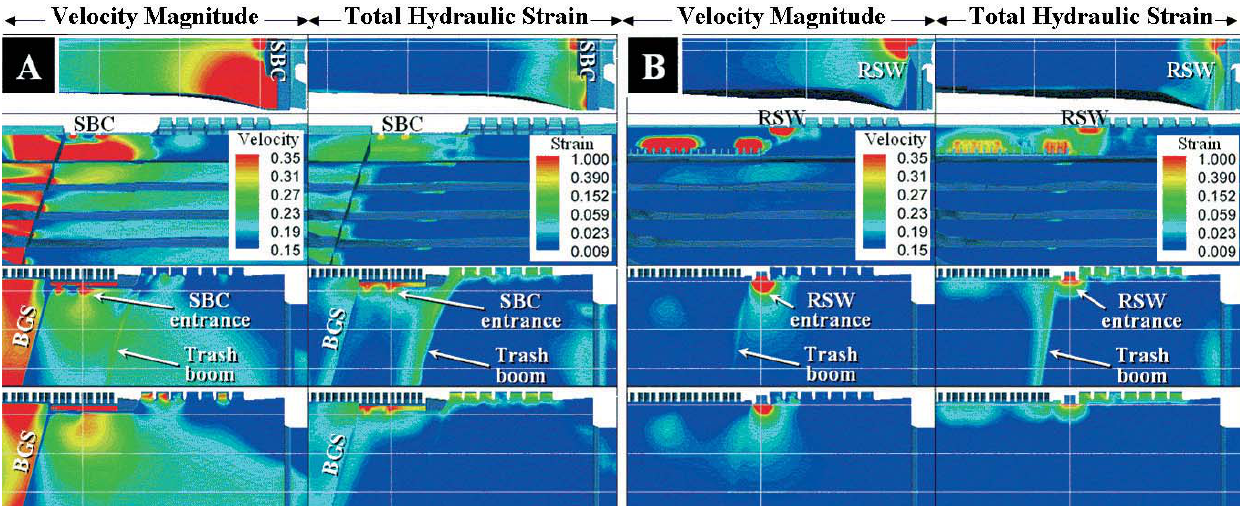
Fig. 5. Patterns in velocity magnitude (m/s) and total hydraulic strain (s -1 ) for the Lower Granite Dam SBC in 2000 [A] and RSW in 2003 [B]. Dam operations described in Goodwin et al. (2006). Each of the two configurations is described with 4 paired velocity magnitude and total hydraulic strain plots. For each grouping, top plots depict a cross-section through the bypass structure (middle entrance of SBC in 2000 and RSW in 2003), 3-D plots in each grouping are cross-sections parallel to dam face at 50 m intervals, and the two bottom plots are horizontal plan views (z = 37 and 42.25 m) showing the change in hydrodynamic pattern at different locations and